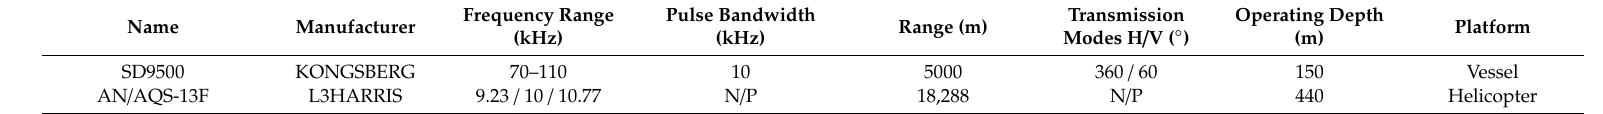
Table 16. Acoustic sensor: dipping